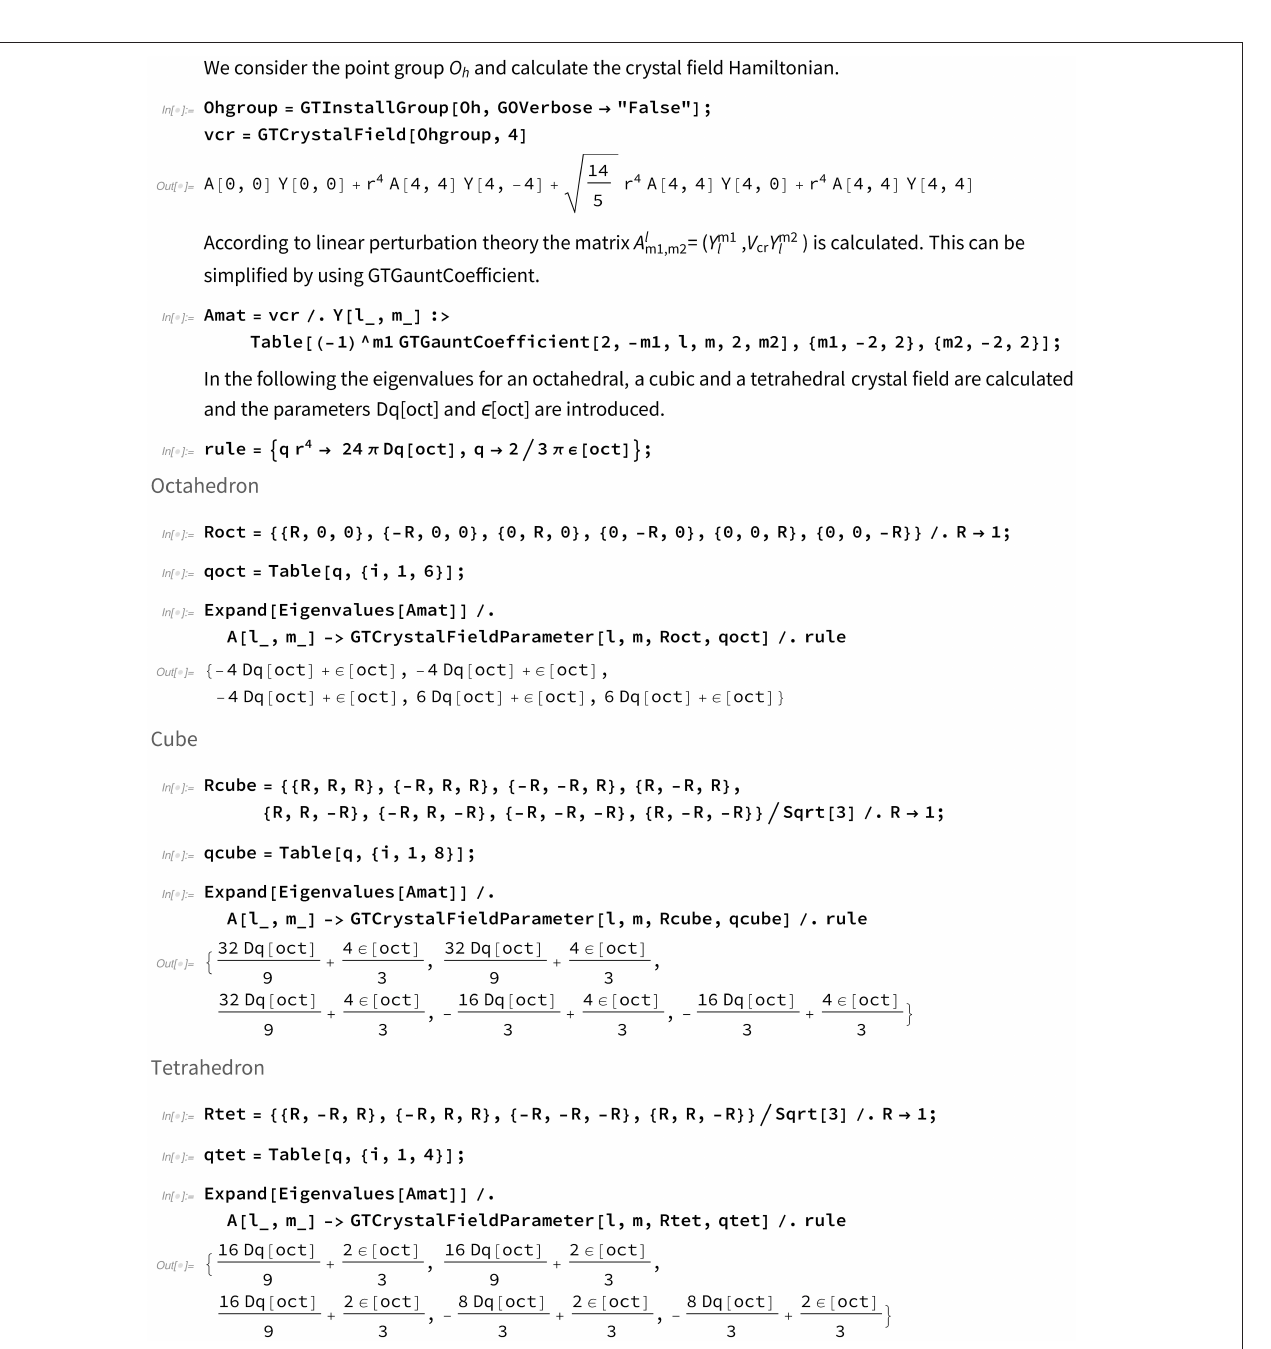
FIGURE 4 | Crystal field expansion and level splitting for a localized d -electron in an octahedral, a cubic and a tetrahedral crystal